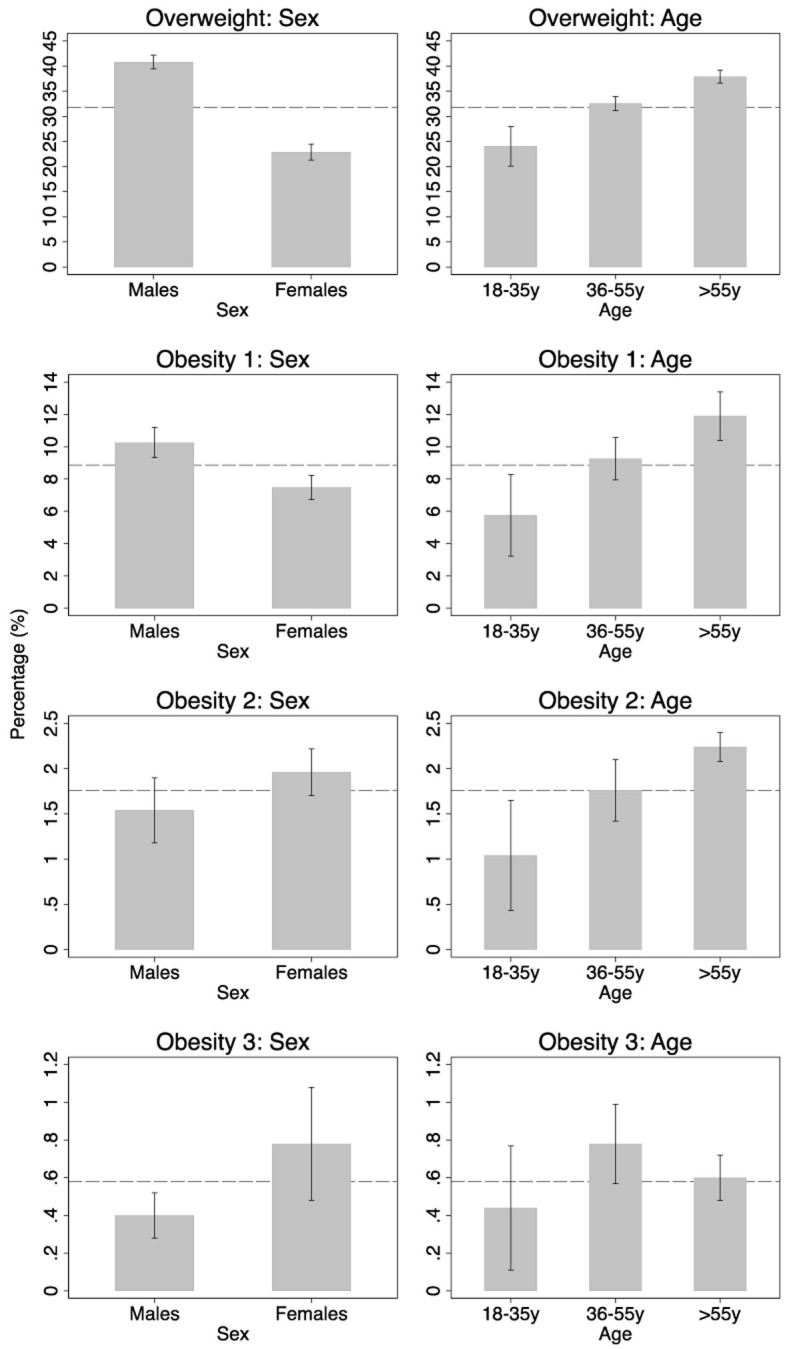
Overall estimation of the prevalence (incl. 95% CI) of World Health Organization (WHO) body mass index (BMI) categories across all 5 included representative data sets, stratified by sex (left column) and age groups (right column).The vertical dashed lines indicate the overall estimations from
Table 1. The precise results can be found in
Table 4.